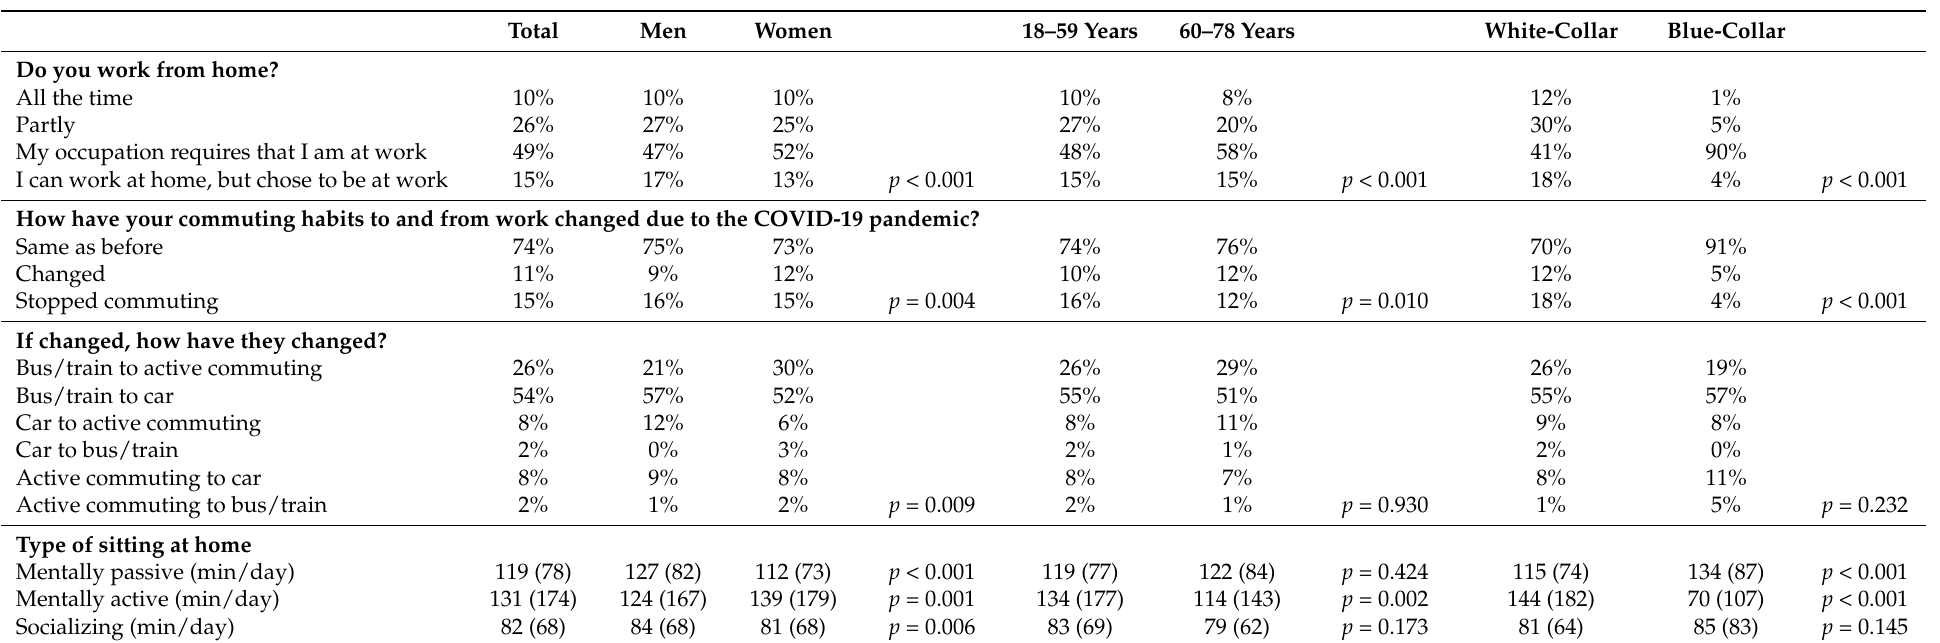
Table 2. Working and commuting situation, and type of sitting at home during the study period. Total